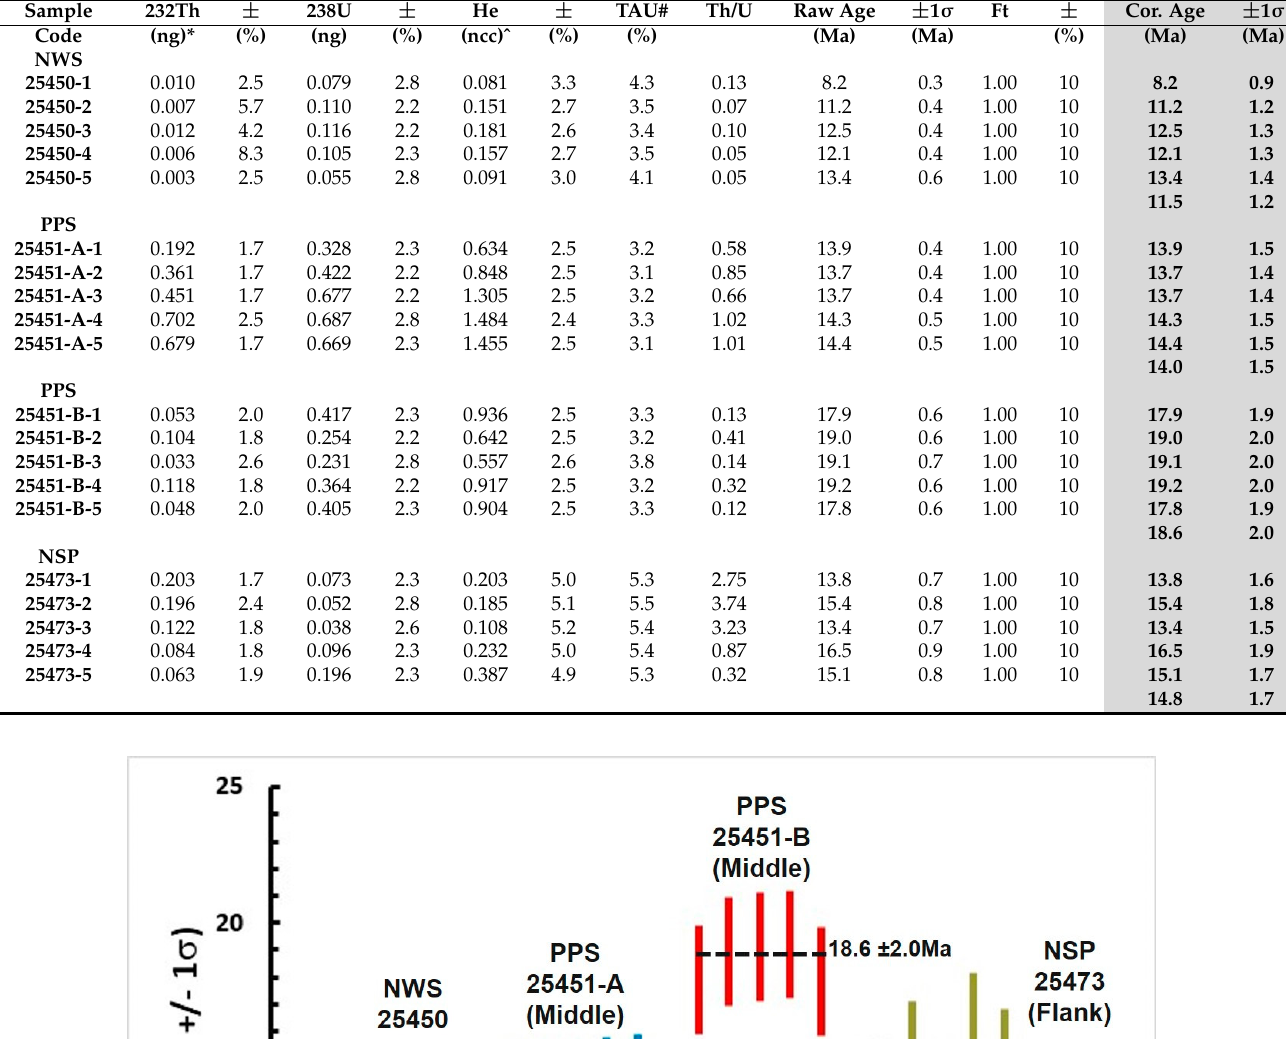
Table 3. Dating results for all sample replicates, with the calculated average (U–Th)/He age and error for each sample highlighted in grey.